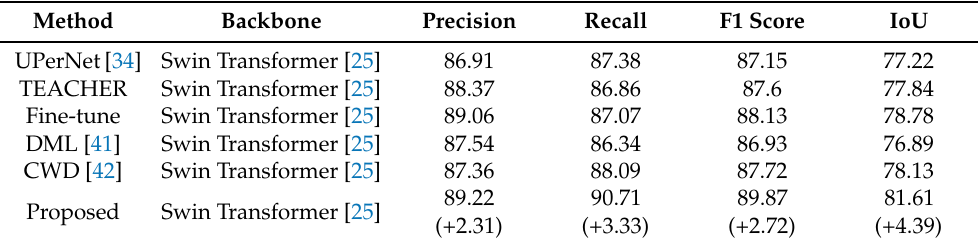
Table 2. Comparison of experimental results for the proposed approach with the combined teacher knowledge